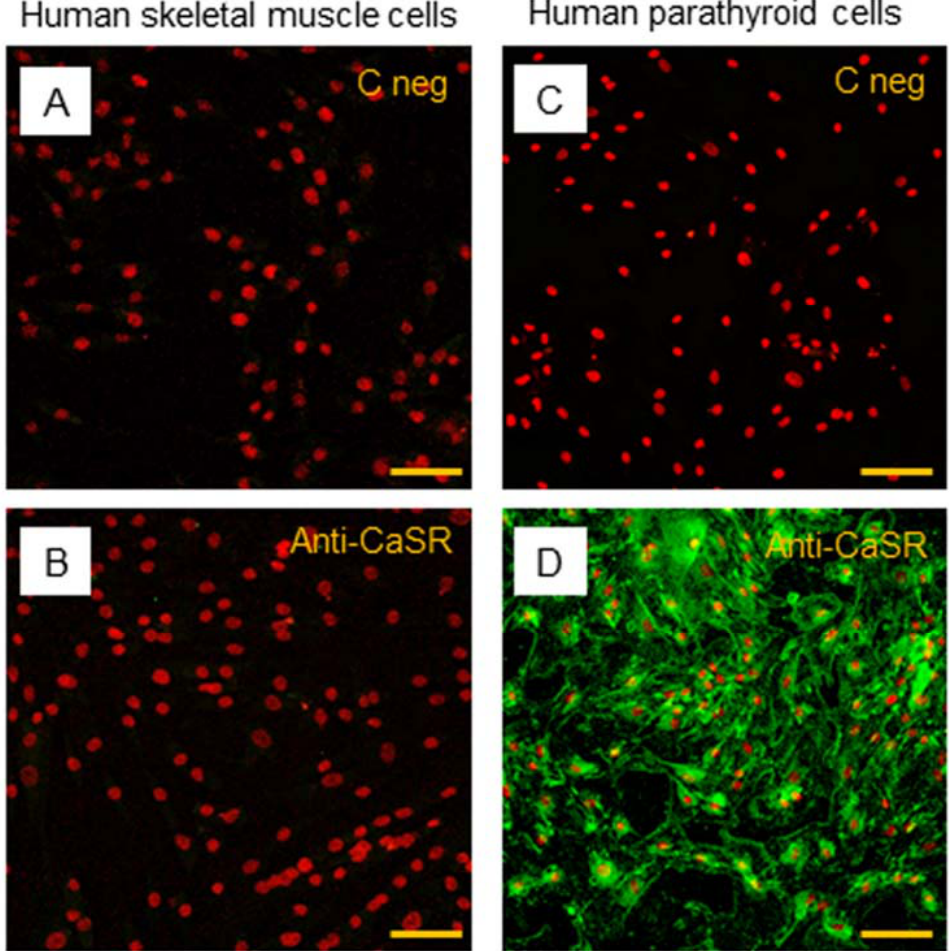
Figure 7. Immunostaining of CaSR in hSC lines. The analysis of CaSR protein in hSC lines: ( A ) negative control with only secondary antibody and ( B ) with primary anti-CaSR antibody. Results are representative of experiments carried out in three established hSC lines. The analysis of CaSR protein was also performed in human parathyroid cells, used as positive control, ( C ) negative control with only secondary antibody, and ( D ) with primary anti-CaSR antibody. LSCM conventional colors: green for CaSR protein and red for nuclei, original magnification: 20×, scale bar: 50 µm.